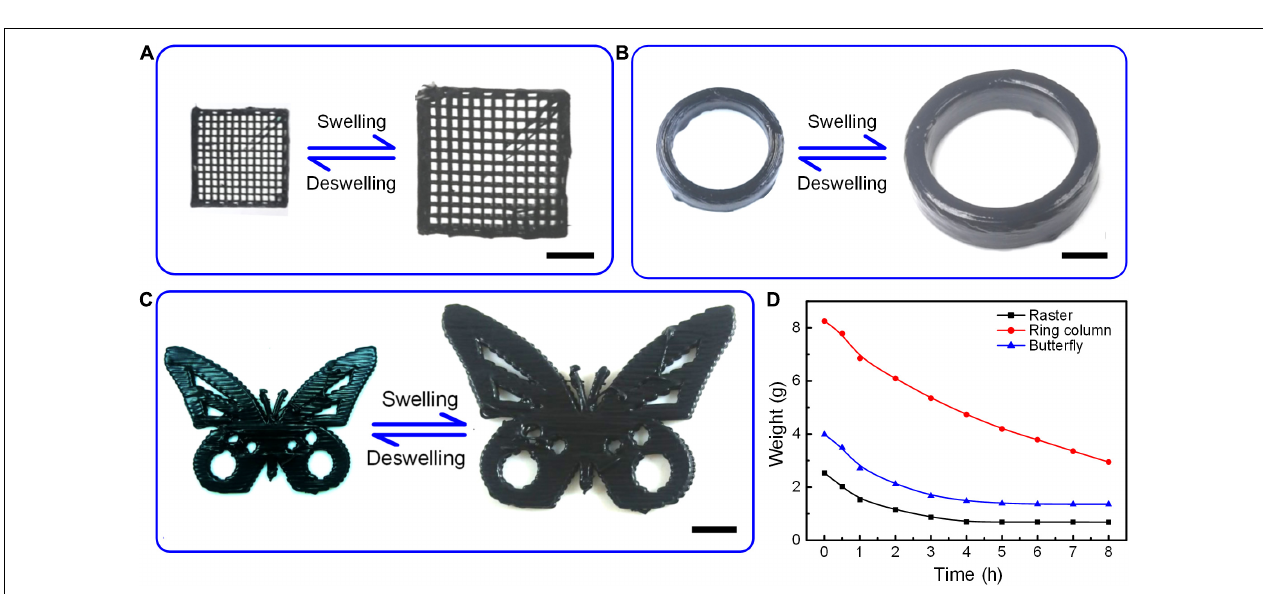
FIGURE 4 | Three printed PU samples with raster structure (A) , ring column (B) , and butterfly shape (C) and their shapes after water-swelling. (D) Changes in the weight of three printed samples during the deswelling process at room temperature.